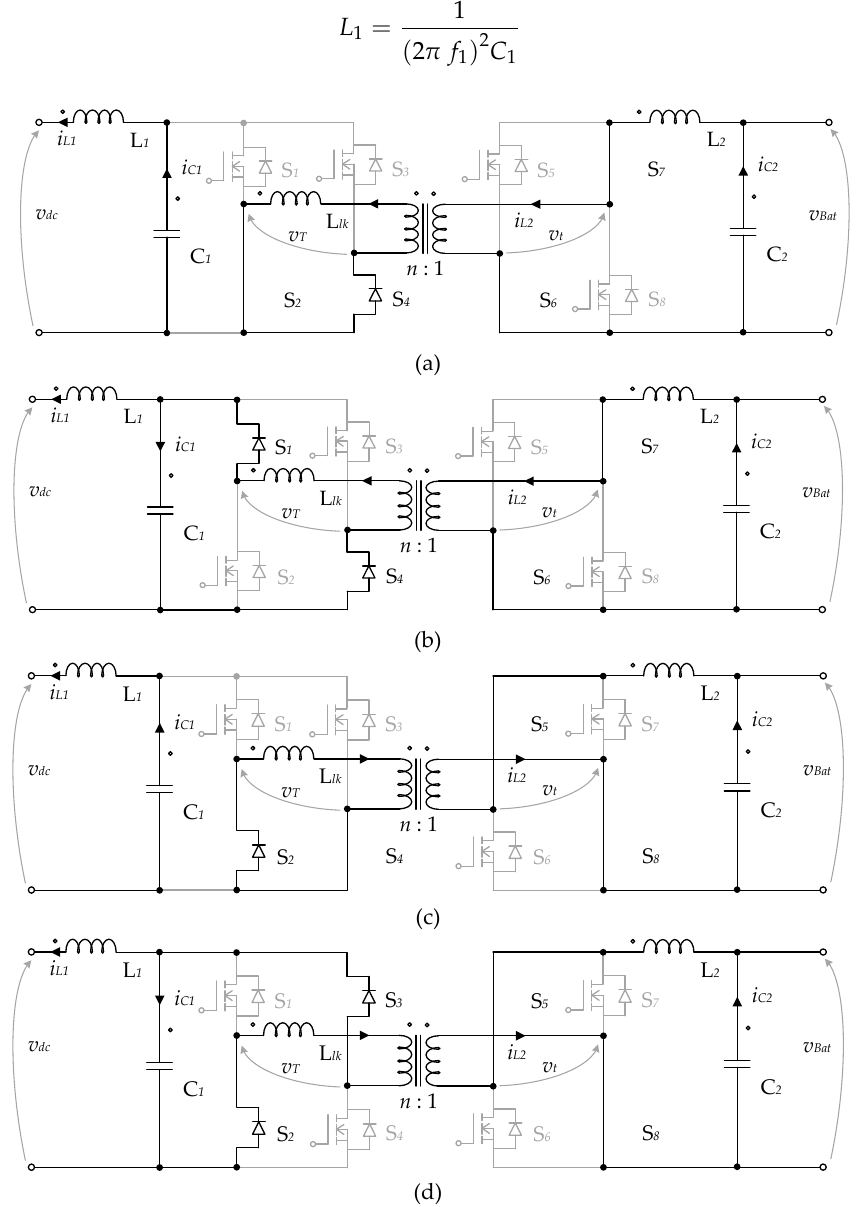
Figure 4. Equivalent circuits of the converter power stages operating in step-up mode, during battery discharging: ( a ) Stage 1, ( b ) Stage 2, ( c ) Stage 3, ( d ) Stage 4.